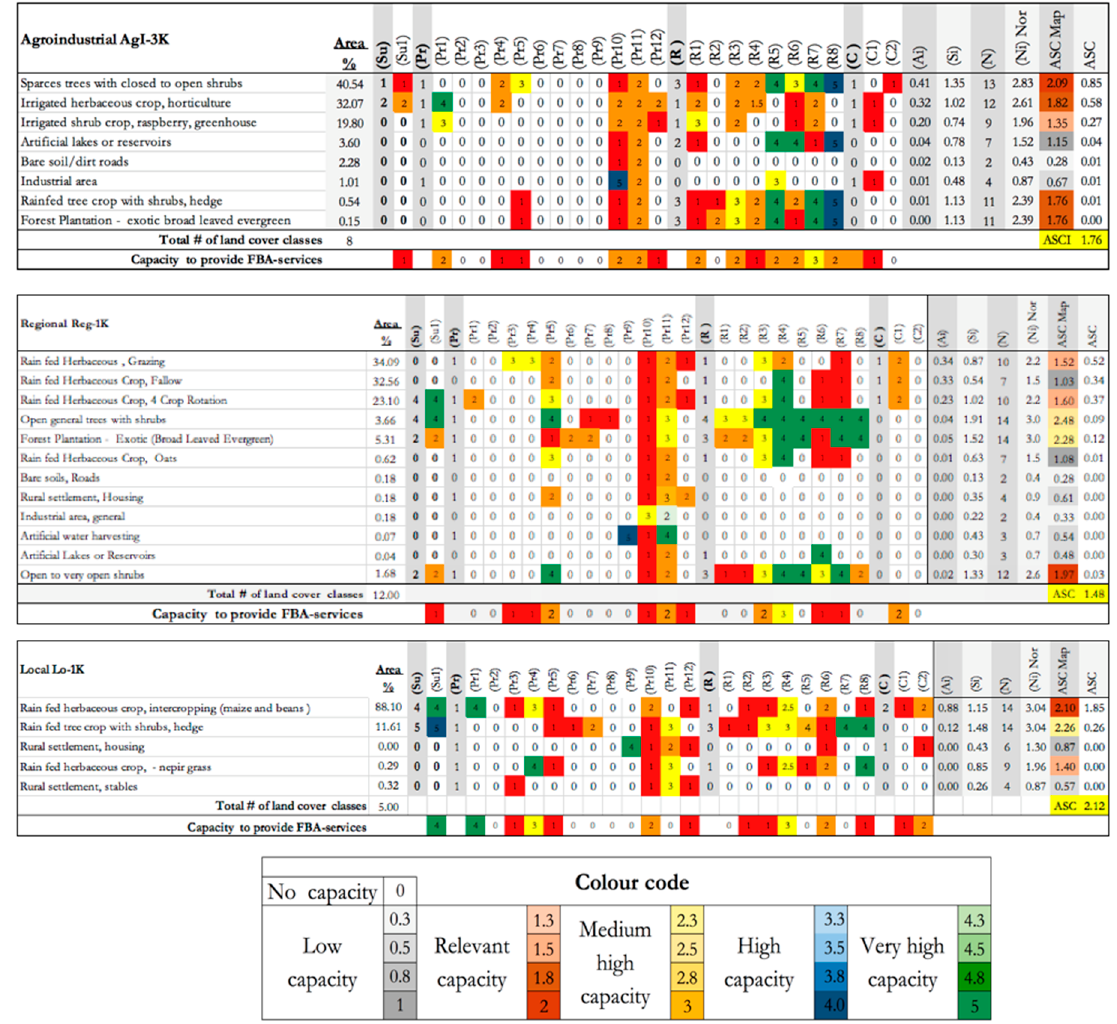
Figure 7. Agroecosystem service matrix of three farm-based agroecosystems in Kenya.